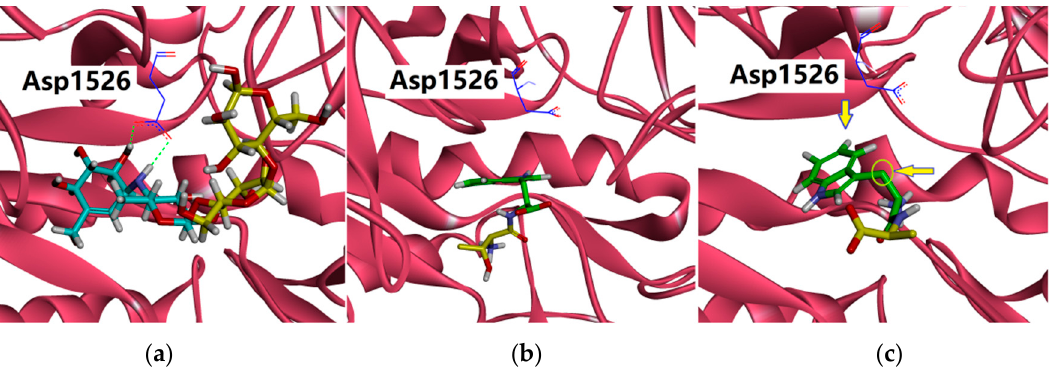
Figure 9. ( a ) The binding pose of acarbose at the active site of MGAM (blue: sugar ring 1 and ring 2; yellow: sugar ring 3 and ring 4), ( b ) the binding pose of TW at the active site of MGAM and ( c ) the binding pose of WA at the active site of MGAM.